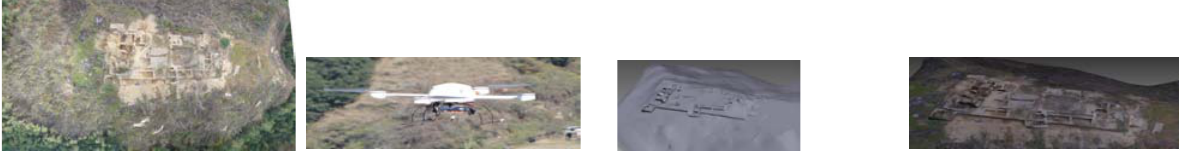
Figure 1: overview of surveying with a UAV system (Microdrone MD4-200) and photogrammetric results achieved from the acquired images: digital surface model, and textured